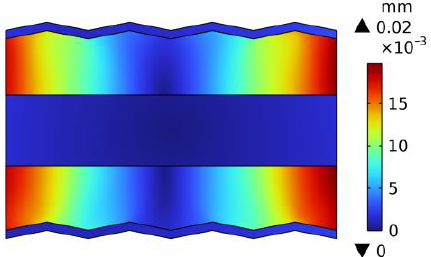
Figure 7. Diagram of the displacement of every particle in the lengthwise cross-section of the cable.